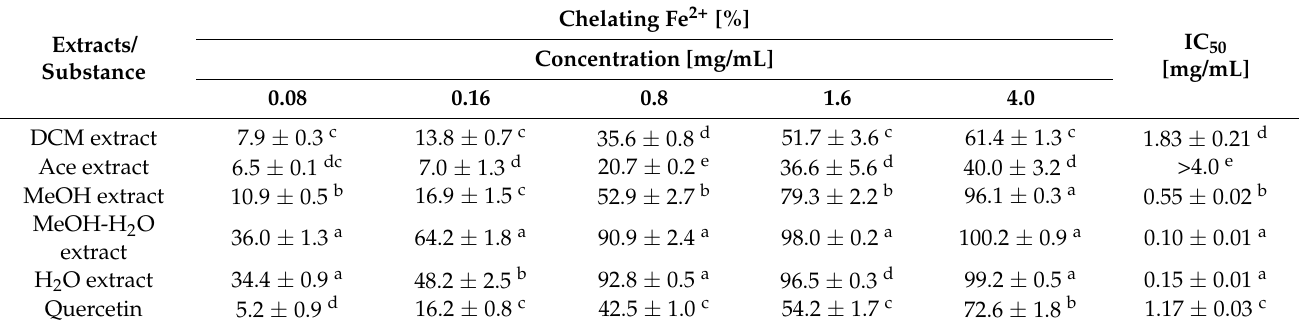
Table 4. Fe 2+ chelating activity of lichen extracts and quercetin as the